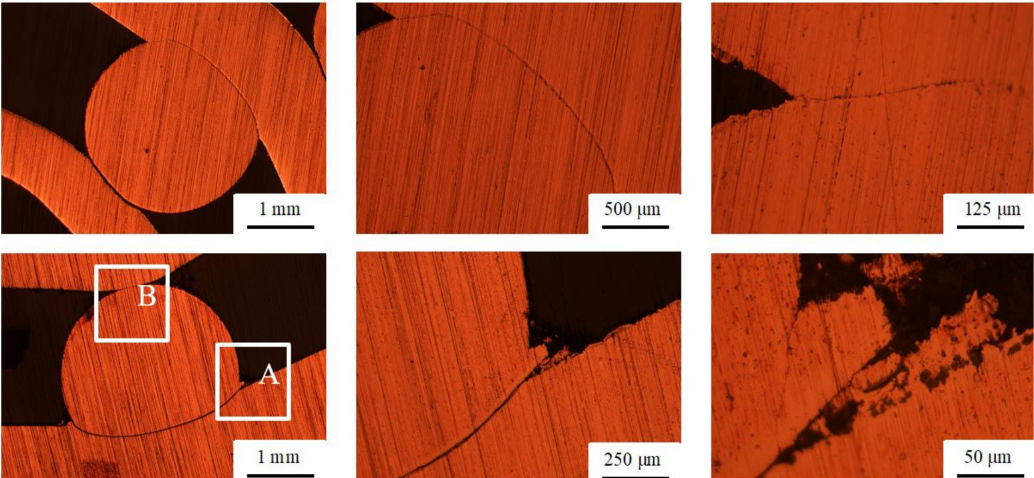
Figure 6. Metallographic images of transversal cross-sections (upper row: specimen #1.1, lower row: specimen